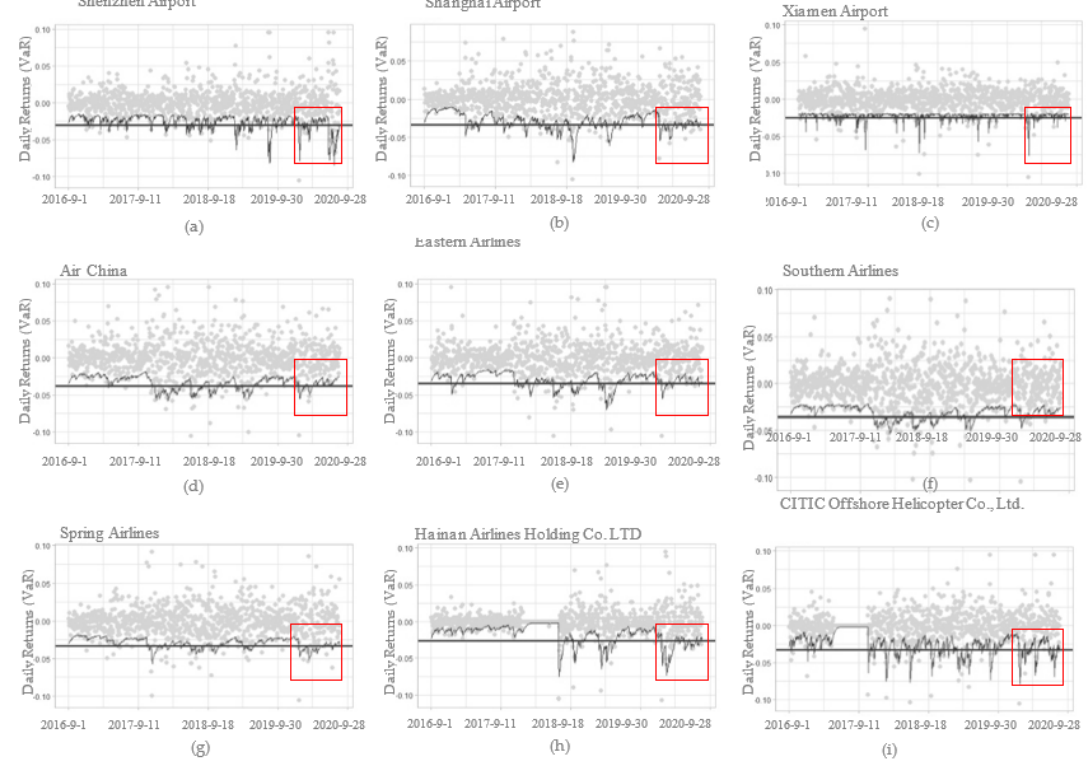
Figure 4. VaR Value of Daily Returns of the Stock Index in Airline Related Firms (Except for Stocks within No ARCH Effects, 31 August 2016–1 September 2020). Note: 1. The volatility curve is the VaR outcome of the GARCH model, while the thick black line is the outcome of the normal distribution; 2. The red box represents volatility during the COVID-19 period.